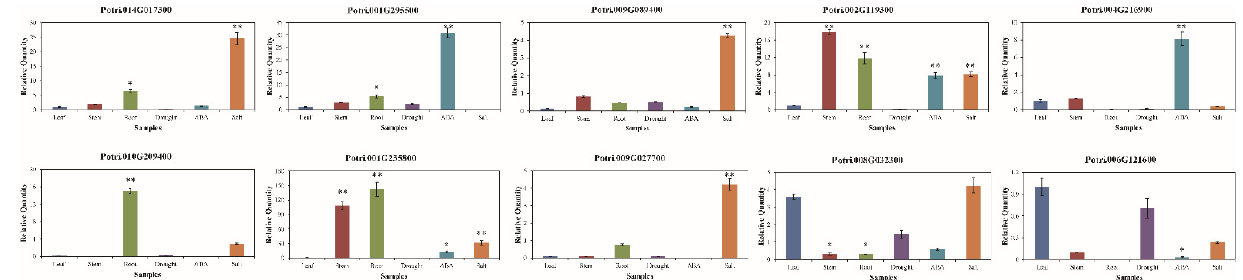
Figure 4. Expression of PtriZAT genes under stress treatment and different tissues. EF1 was used as an internal control. Data are means of three biological replicates and error bars are ± SE from three independent experiments, each performed with 2–3 leaves from three separate plants, asterisks indicate significant differences by Tukey LSD test (* p < 0.05, ** p < 0.01).